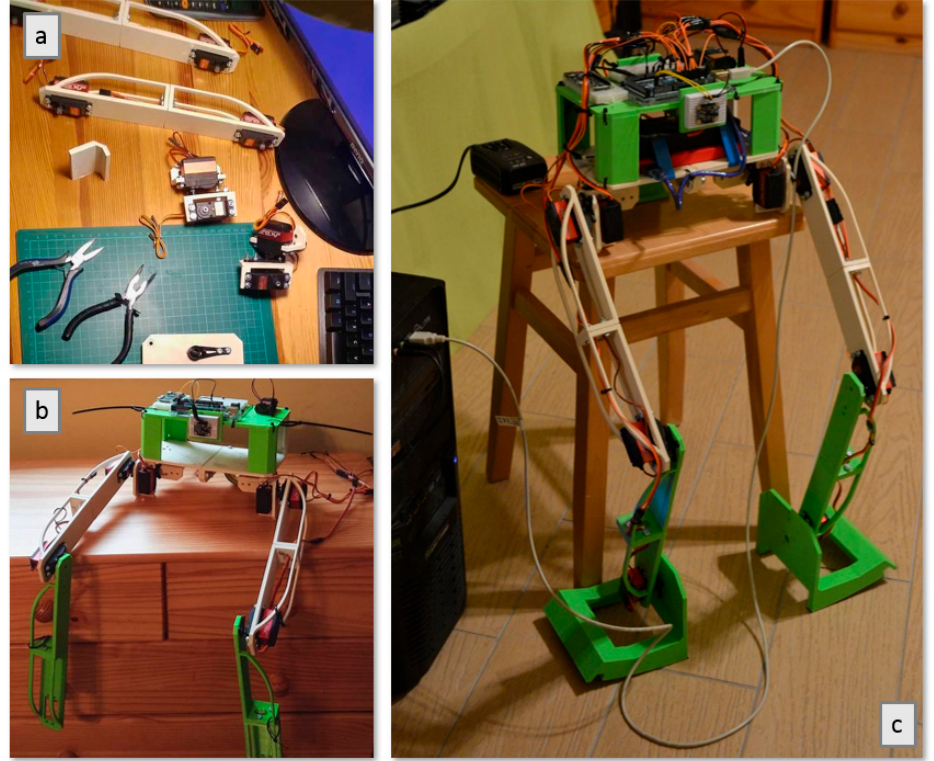
Figure 14. A tested prototype of bipedal robot MaRoŠ ( a ) construction parts; ( b ) partial construction; ( c ) final version.